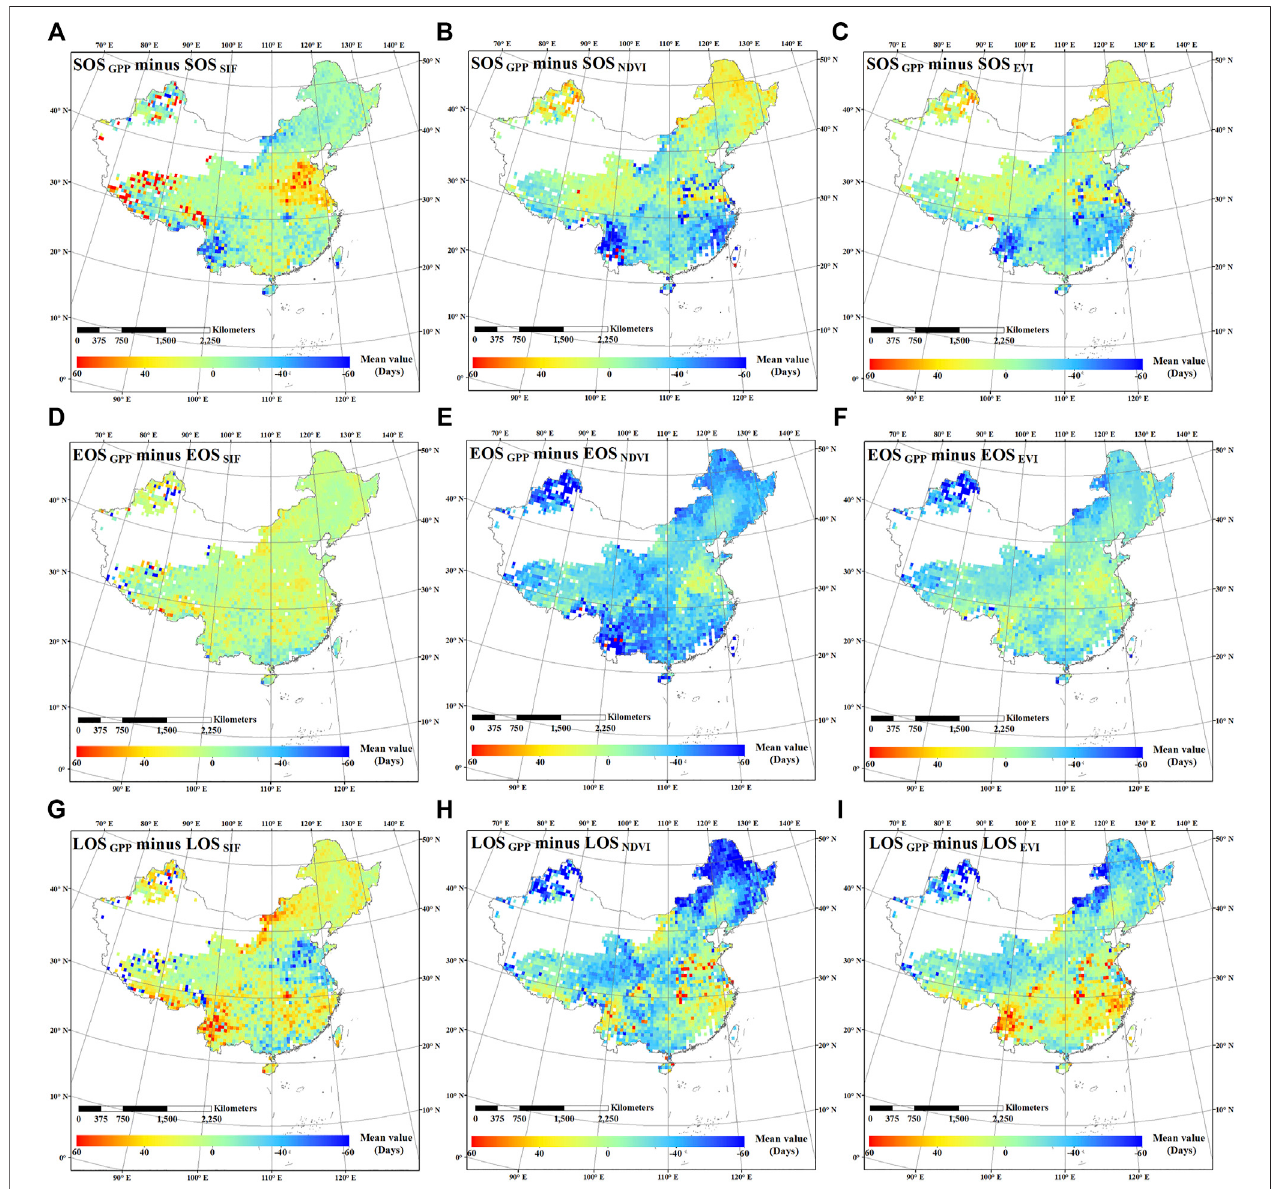
FIGURE 8 | Spatial distributions of the difference between SOS GPP and SOS SIF (A) , EOS GPP and EOS SIF (D) , and LOS GPP and LOS SIF (G) , the difference between SOS GPP and SOS NDVI (B) , EOS GPP and EOS NDVI (E) , and LOS GPP and LOS NDVI (H) , and the difference between SOS GPP and SOS EVI (C) , EOS GPP and EOS EVI (F) , and LOS GPP and LOS EVI (I) in